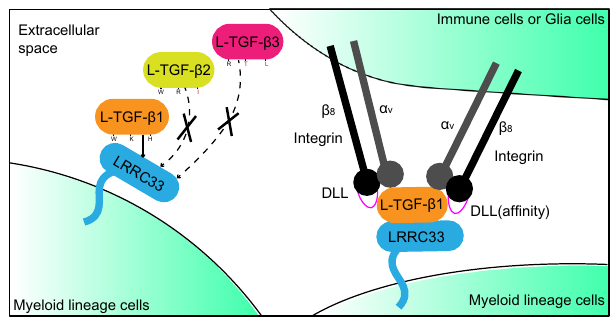
Fig. 6 | Schemetic model for the speci fi c TGF- β 1 signal of the myeloid lineage cells designated by LRRC33 and integrin α V β 8 . The three key residues that determine the speci fi c cell-surface L-TGF- β 1 presentation by LRRC33 are labeled. The cognate residues of L-TGF- β 2 and L-TGF- β 3 are also indicated with the major discriminative ones colored in